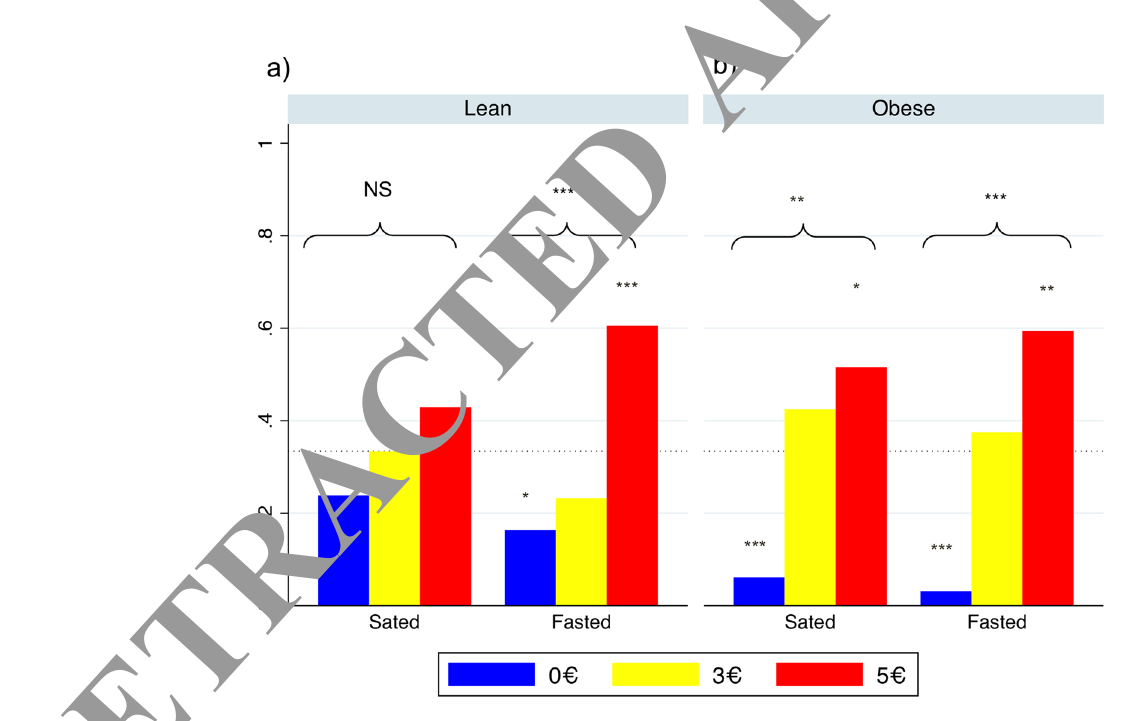
Figure 1. Proportions of subjects reporting red (€5), yellow (€3), and blue (€0) outcomes. Panel ( a ) is for lean subjects and panel ( b ) for obese subjects under the Sated and Fasted conditions. The dotted line represents outcomes chance level (0.334). ***, **, and * indicate significance at the 0.1%, 1%, 5%, in binomial and chi- square tests. NS for no significance.